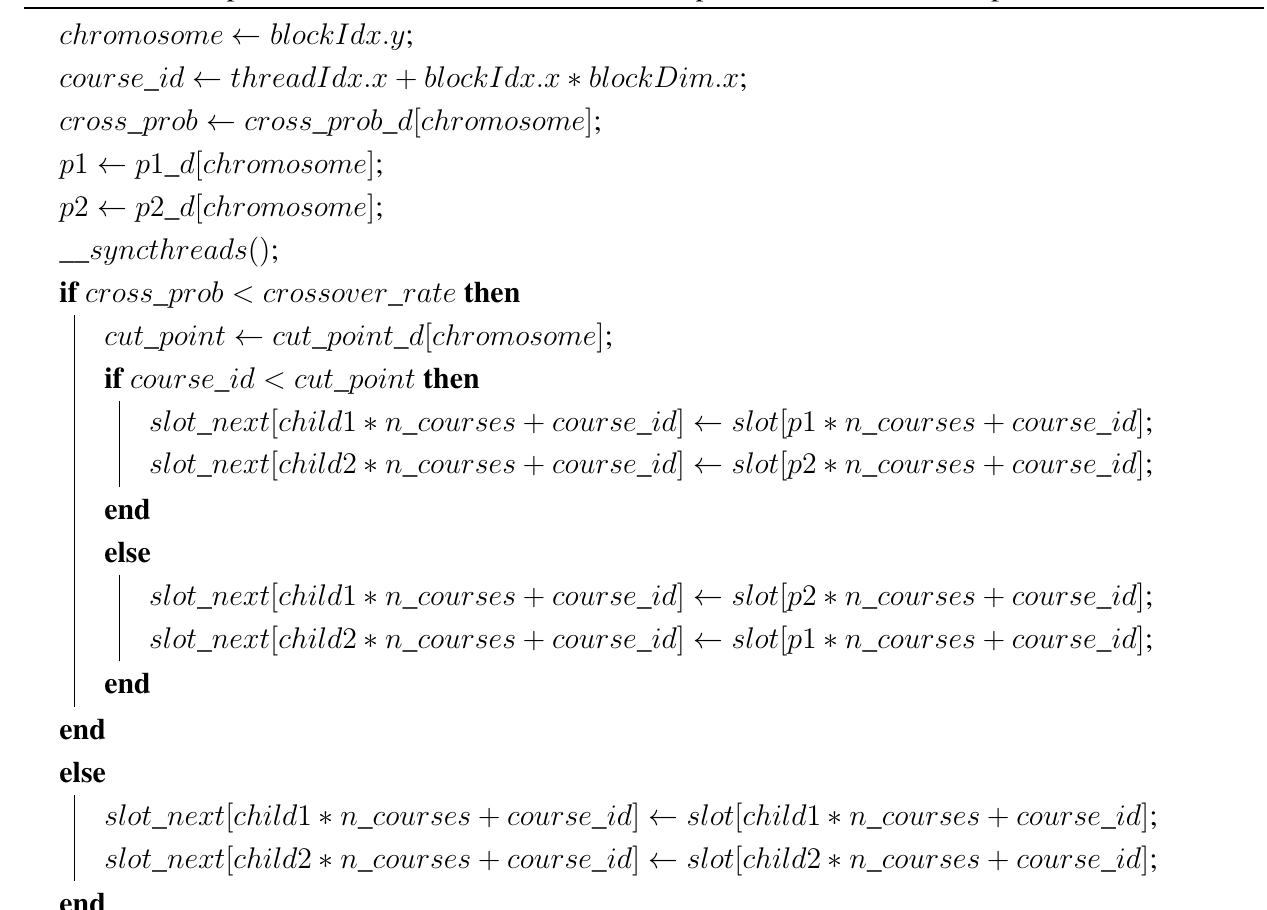
Algorithm 7: Reproduction, examination-threaded approach (two kernels implementation): each thread uses the previous selected chromosomes and implements the crossover